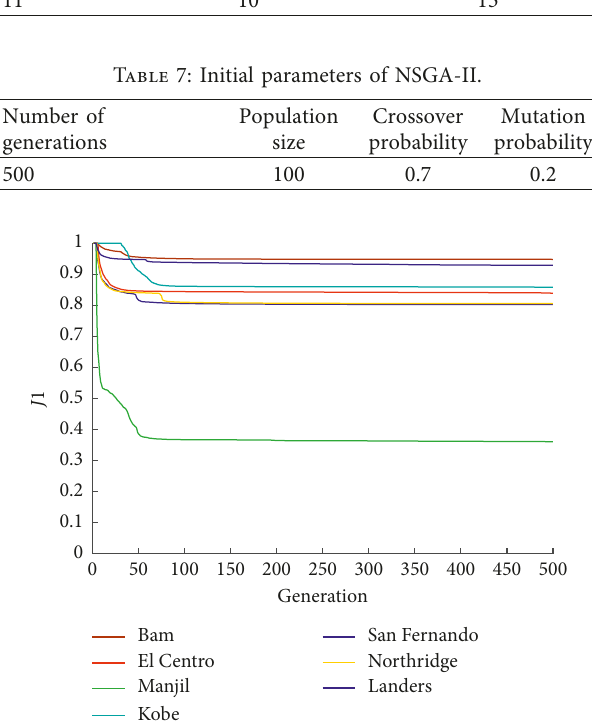
Figure 10: Trend of objectives during the